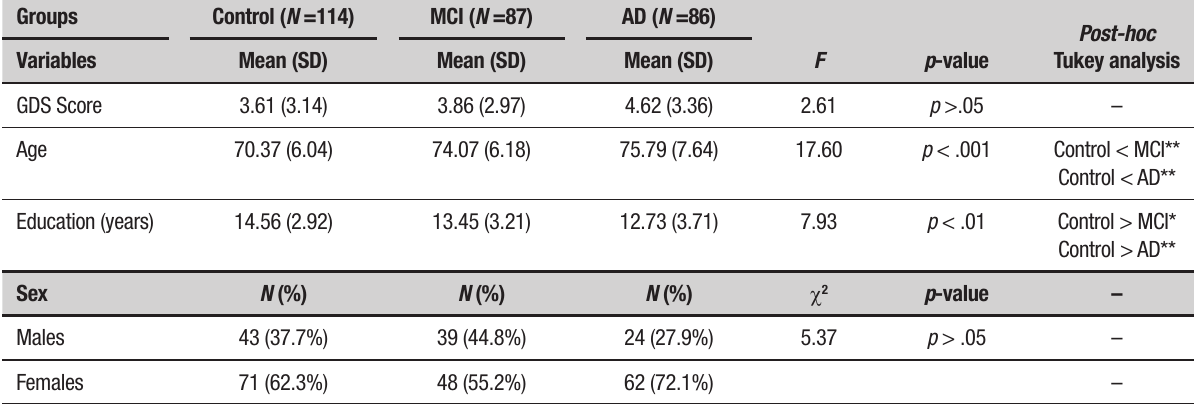
Table 1. Age, Education, GDS Score and Sex: one-way ANOVA and Chi-squared results among the three groups. Groups